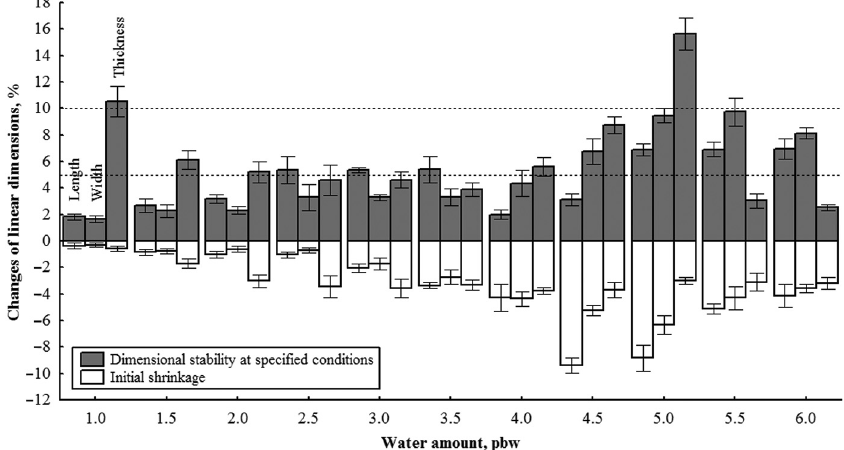
Fig. 3. The dependence of the change in polyurethane foam’s linear dimensions on the amount of water: (------) – maximum allowable changes in dimensions in the directions of length, width and thickness according to EN